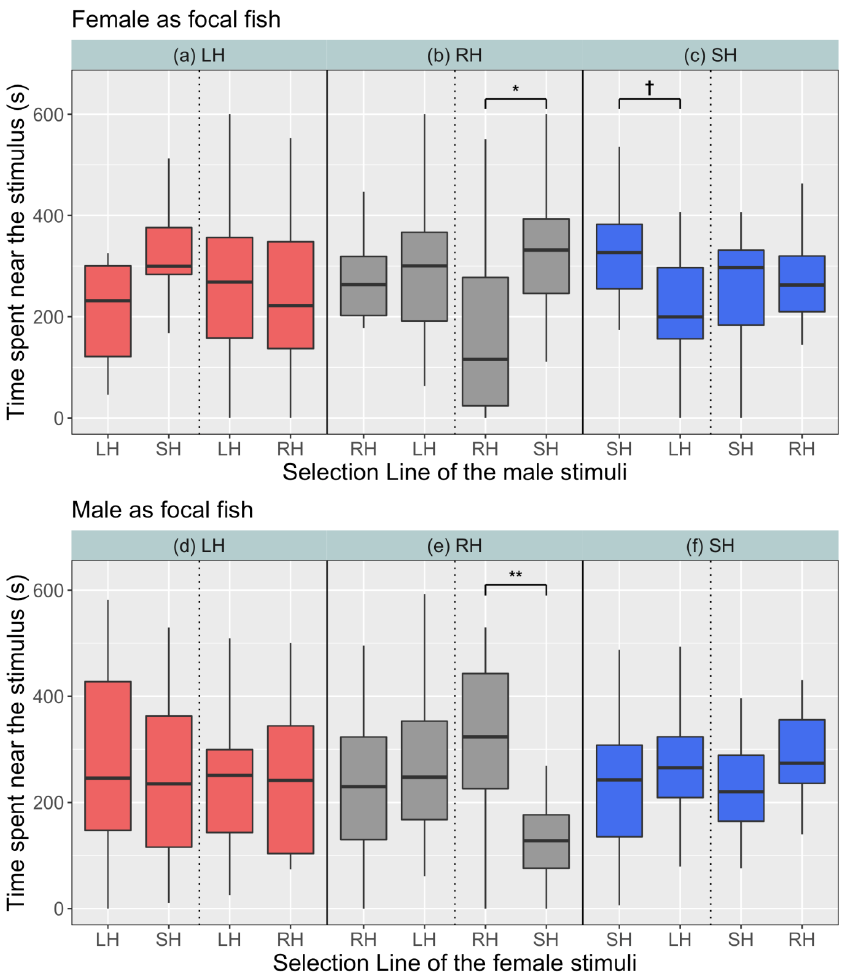
Figure 3. Comparison of prezygotic preferences of female (( a – c )), and male focal fish (( d – f )) across selection lines. The upper x -axis represents focal fish and the lower x -axis represents stimulus fish from the same or different selection lines. Significance codes: ( p < 0.01) ‘**’, ( p = 0.01) ‘*’, ( p > 0.05) ‘†’.